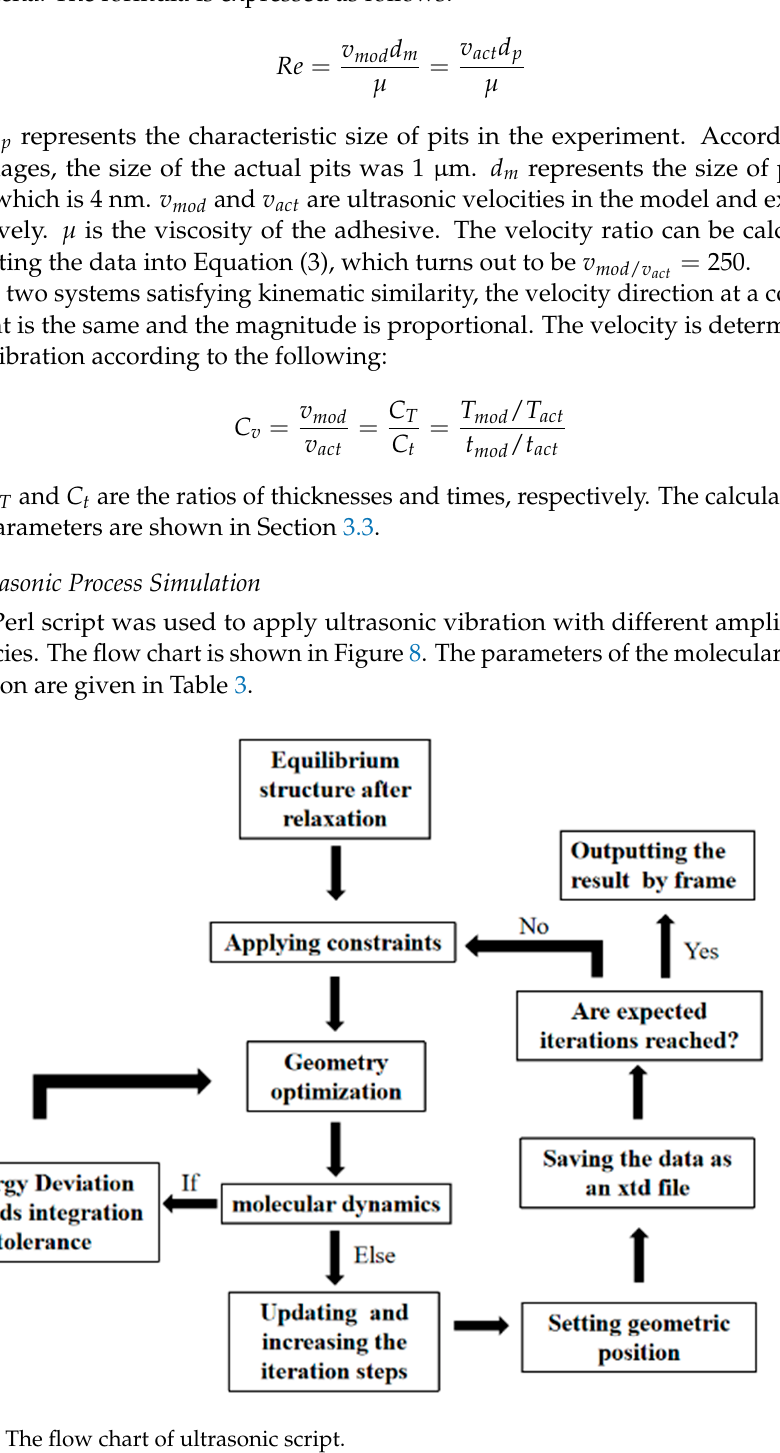
Figure 8. The flow chart of ultrasonic script. The simulation was divided into two parts. In Part 1, the Perl script was set to simulate the ultrasonic process with the same amplitude ( n = 1) but different frequencies (20 kHz, 25 kHz and 30 kHz). The simulation parameters shown in Table 4 were